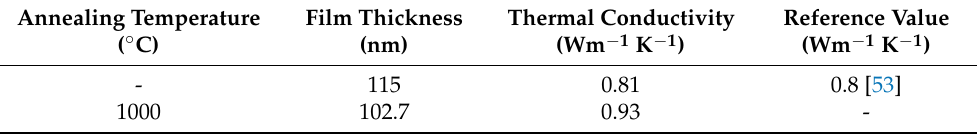
Table 6. Final thermal conductivity measurement results for the different Al 2 O 3